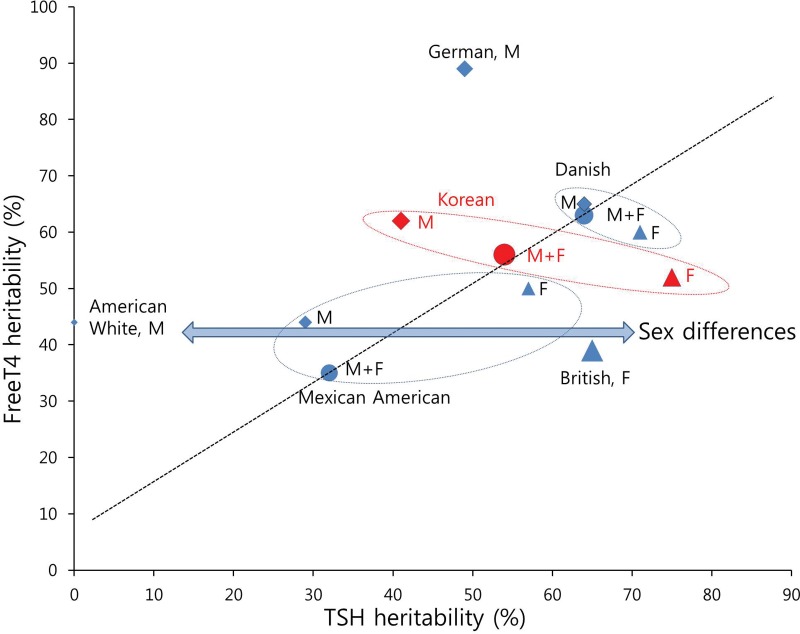
Heritability estimates for TSH and fT4 levels shown in literature and in our study.Overall and sex specific heritability estimates for TSH and fT4 levels from our study and literature[4–9] were plotted. Rhombic markers (M) are male, triangular markers (F) are female, and circle markers (M+F) are male and female. Size of markers represents the number of participants. Ellipse consisting of dotted line indicates a study of the same subject group, or a single study. Region marked “Korean” refers to estimates from this study. Heritability of TSH and fT4 levels shows sex differences (double arrow), as well as proportional tendency (dotted line).